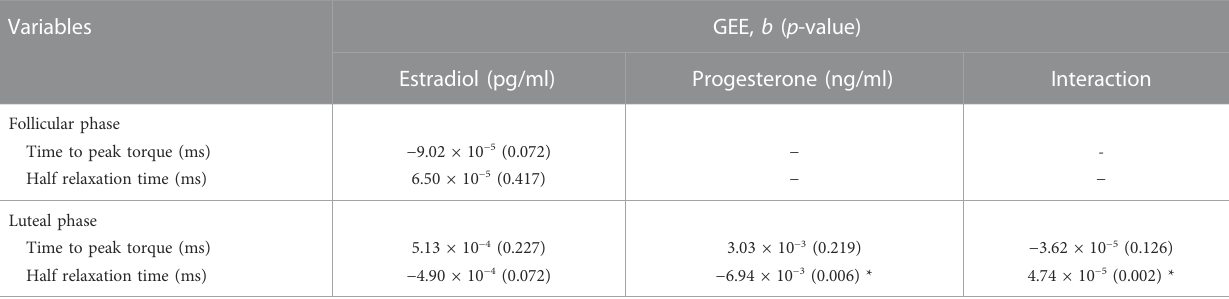
TABLE 2 Generalized estimating equation (GEE) of the main effect of estradiol, progesterone, and estradiol × progesterone interaction on peak torque, time to peak torque, and half relaxation time of muscle twitch across the menstrual cycle. The data were analyzed separately within follicular phase (estradiol concentrations increaseto its maximum while the progesterone concentrations were low) andluteal phase (progesterone concentrationincreased concomitantly with estradiol).